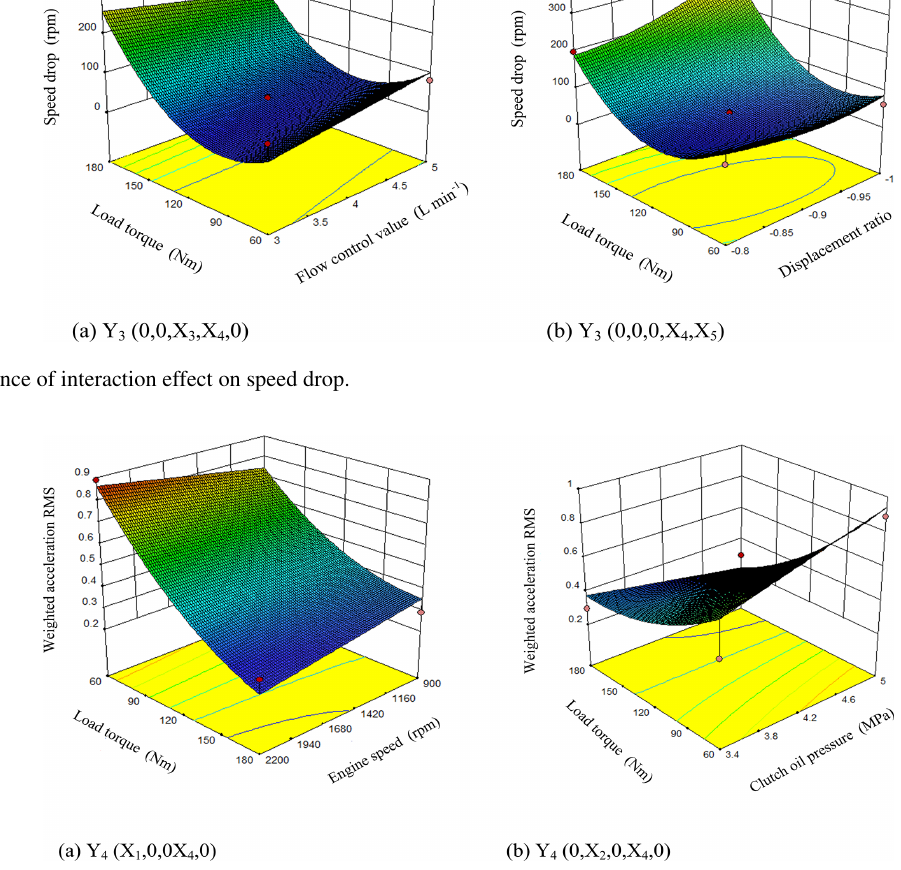
Figure 12. Influence of interaction effect on weighted acceleration RMS.